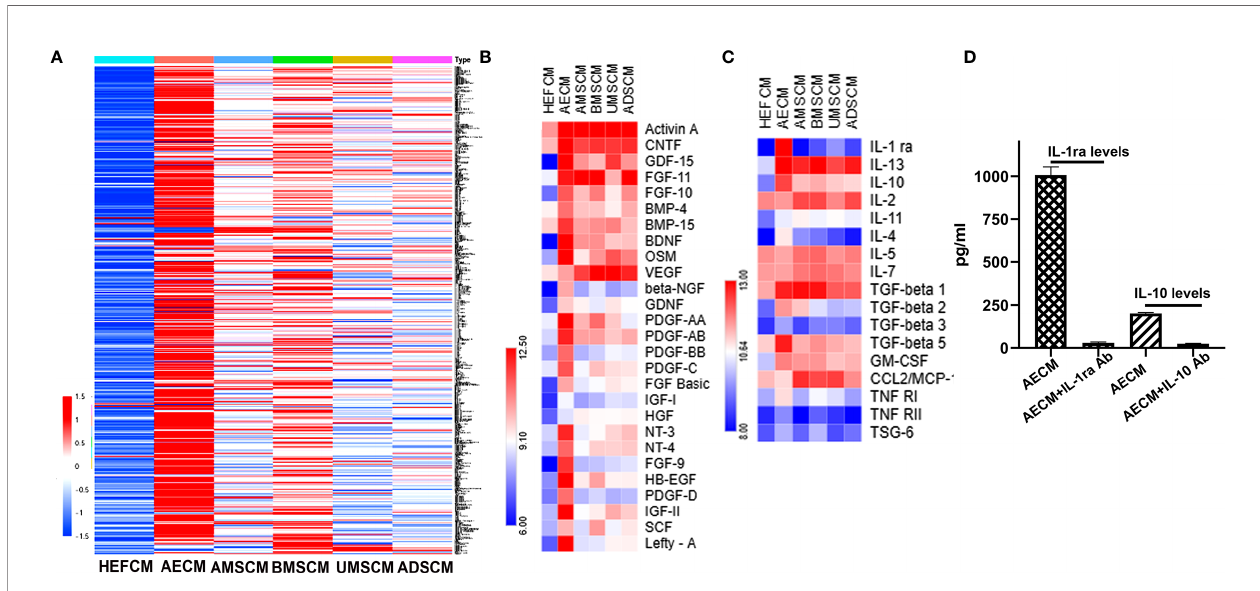
FIGURE 3 | Analysis of paracrine factors secreted by TSC. (A) Soluble factor in the AECM, MSC, AMSCM, BMSCM, UMSCM, and ADSCM were analyzed by a human antibody array 507. HEFCM was used as a control. The normalized array data of 507 proteins in the CM of different tissue stem cells were analyzed by SAM, and the relative concentrations of these factors were shown as a “ heat map ” . (B) The relative concentrations of growth factors were shown as a “ heat map ” . (C) The relative concentrations of anti-allergic-related factors including anti-in fl ammatory factors and TGF- b were shown as a heat map. (D) ELISA analysis of the concentration of IL-1ra and IL-10 in the AECM and their levels when neutralized with their antibodies.